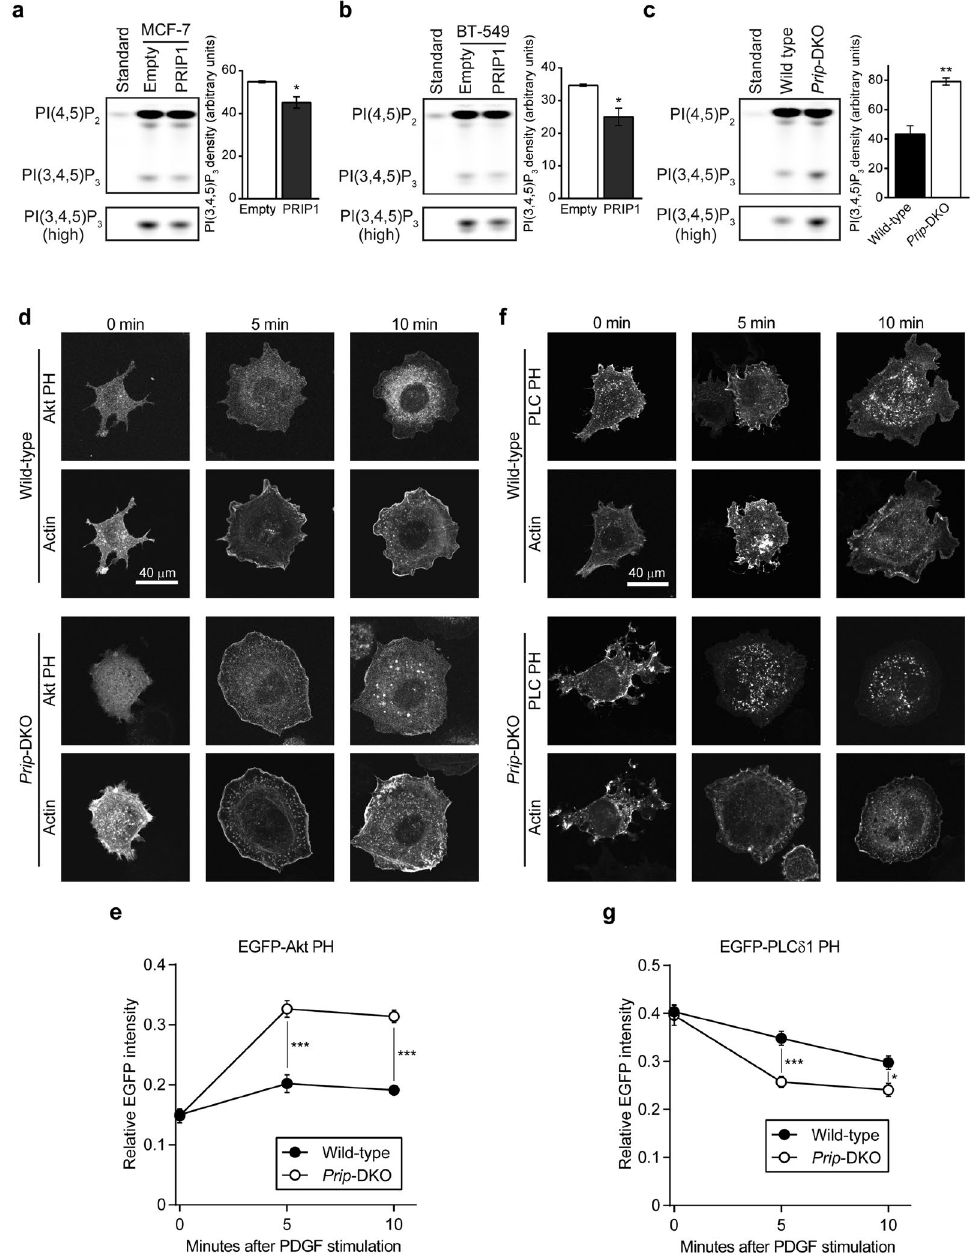
Figure 5. PRIP regulates the alteration of PI(3,4,5)P 3 and PI(4,5)P 2 on the plasma membrane. (a–c) MCF-7 ( a ) and BT-549 ( b ) cells stably expressing EGFP-tagged Prip1 and DsRed2-tagged Prip1 , respectively, and cells transfected with empty vectors ( a , b ) and wild-type and Prip -DKO MEFs (c) were used for experiments. Cells were incubated with BODIPY FL-PI(4,5)P panel (standard) shows the chromatographic mobility of 1 nmol fluorescent PI(4,5)P 2 . The lower panels were obtained using a high sensitivity mode (high). Similar data were obtained from three independent experiments, and representative images are shown. The PI(3,4,5)P 3 bands were quantified using ImageJ software. Data are presented as means ± SEM [ (a – c ), n = 3 per group]. ( d – g ) MEFs transfected with either EGFP-tagged Akt PH ( d , e ) or EGFP-tagged PLC δ PH ( f , g ) and Kusabira-Orange-tagged actin were stimulated with 20 ng/mL PDGF for the indicated period of time. Similar data were obtained from at least three independent experiments, and representative images are shown ( d , f ). Fluorescence intensity of EGFP-Akt PH (e) and EGFP-PLC δ PH ( g ) on the plasma membrane was measured and normalised by the intensity of whole cells. The data are presented as means ± SEM determined at 0, 5, and 10 min [( e ) wild-type, n = 36, 23, and 36; Prip -DKO, n = 38, 58, and 58; ( g ) wild-type, n = 41, 34, and 20; and Prip -DKO, n = 26, 49, and 19, respectively, in the left-to-right direction on the graph]. * p < 0.05, ** p < 0.01, *** p < 0.001 versus the corresponding control value ( a – c ) or between the indicated bars ( e , g ) (Mann–Whitney U